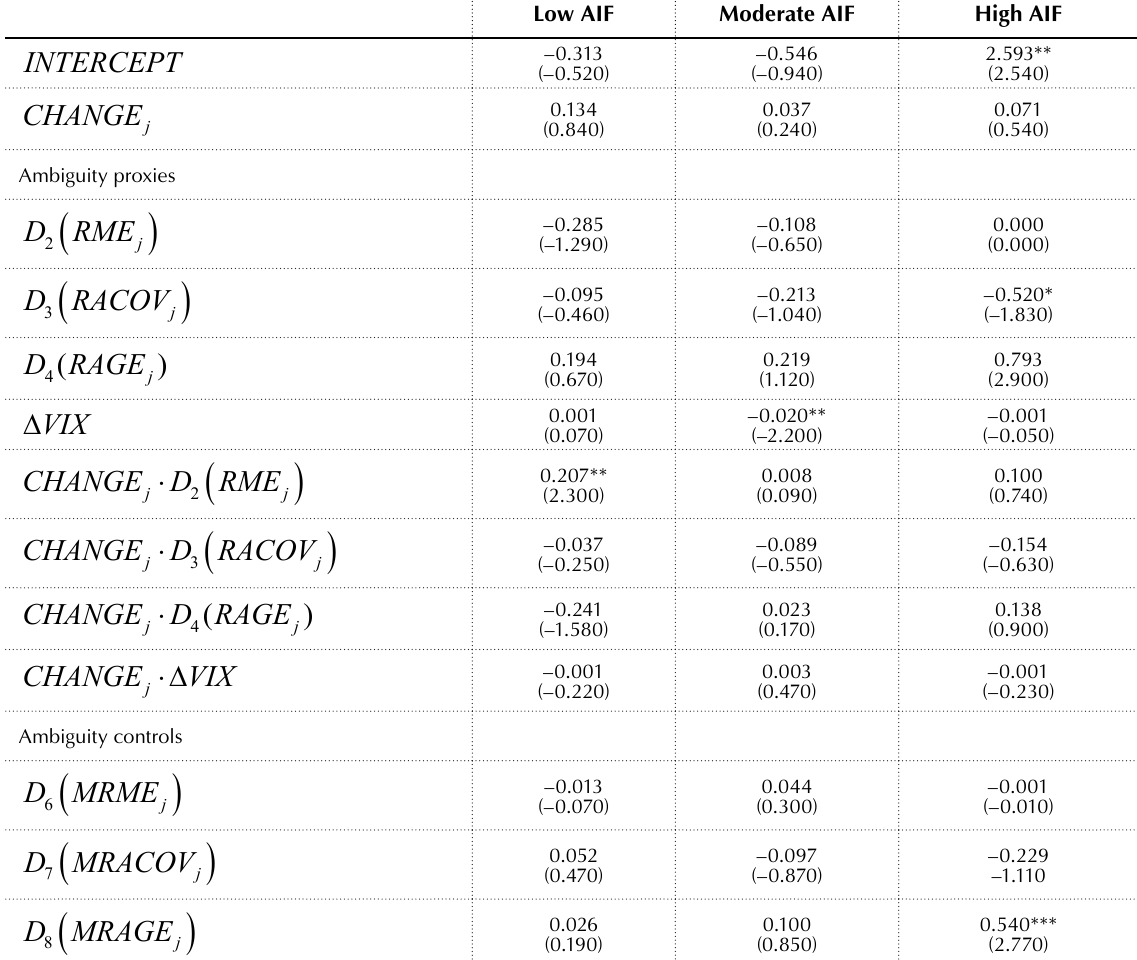
Table 6. The effects of ambiguity in information and market ambiguity on BHARs under different levels of ambiguity in fundamentals